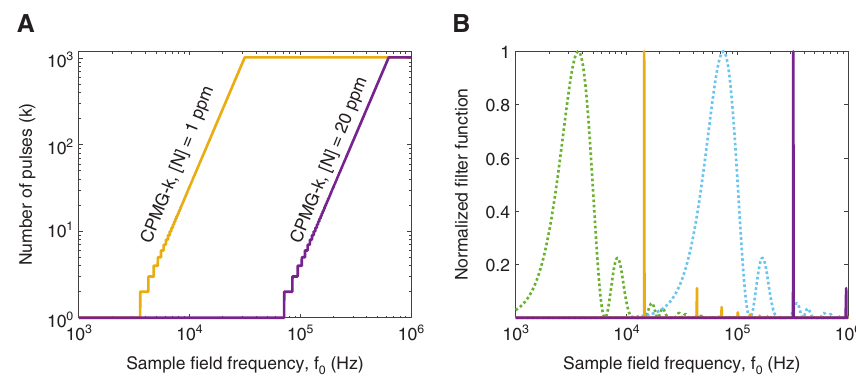
Figure 12: CPMG protocol bandwidth. (A) The optimal number of pulses for the CPMG protocol changes with the sample field frequency. (B) Example filter functions S ( f ) at the most sensitive sample frequencies for each of the CPMG curves in Figure 11. Dotted lines represent the response for a one-pulse CPMG. Solid lines are for the most sensitive center sample field frequencies for CPMG limited to 1024 pulses. The solid lines are ∼ 1000 times narrower than the dotted lines due to having ∼ 1000 times more